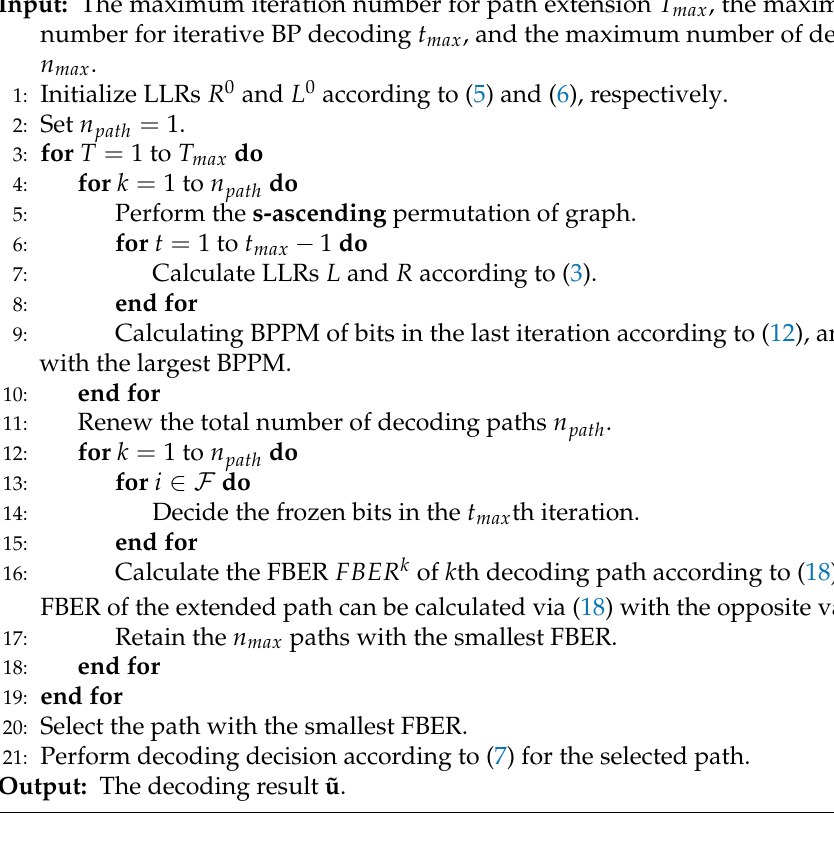
Algorithm 1 The proposed IBPL decoder.